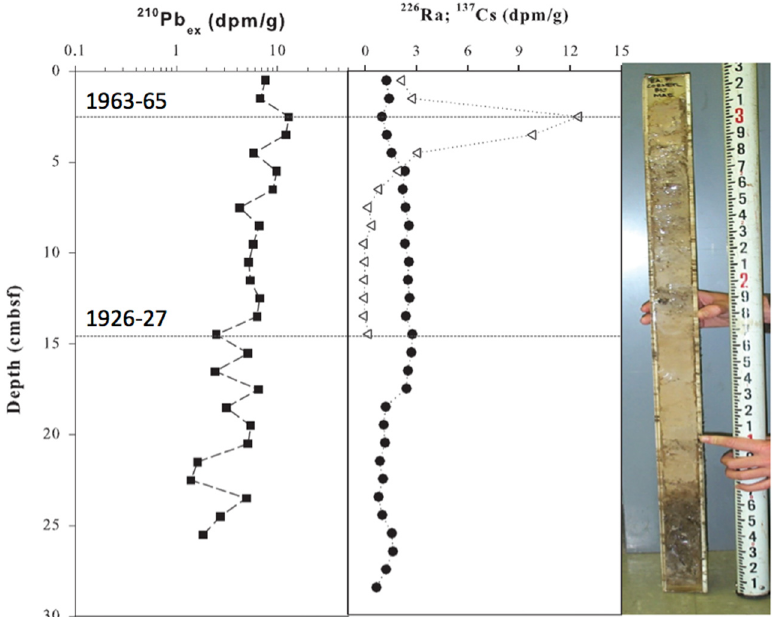
Figure 4. Recent accretion rates were estimated using 210 Pb ex ( left ) and 137 Cs ( middle ) dating to isolate the sediment layer associated with 1927 flood deposition ( right ). The top of the sediment layer occured at 15 cm, which is about 1926–27. Above the sediment layer, accretion rates were about 2.5–3.0 mm·year − 1 for this location.